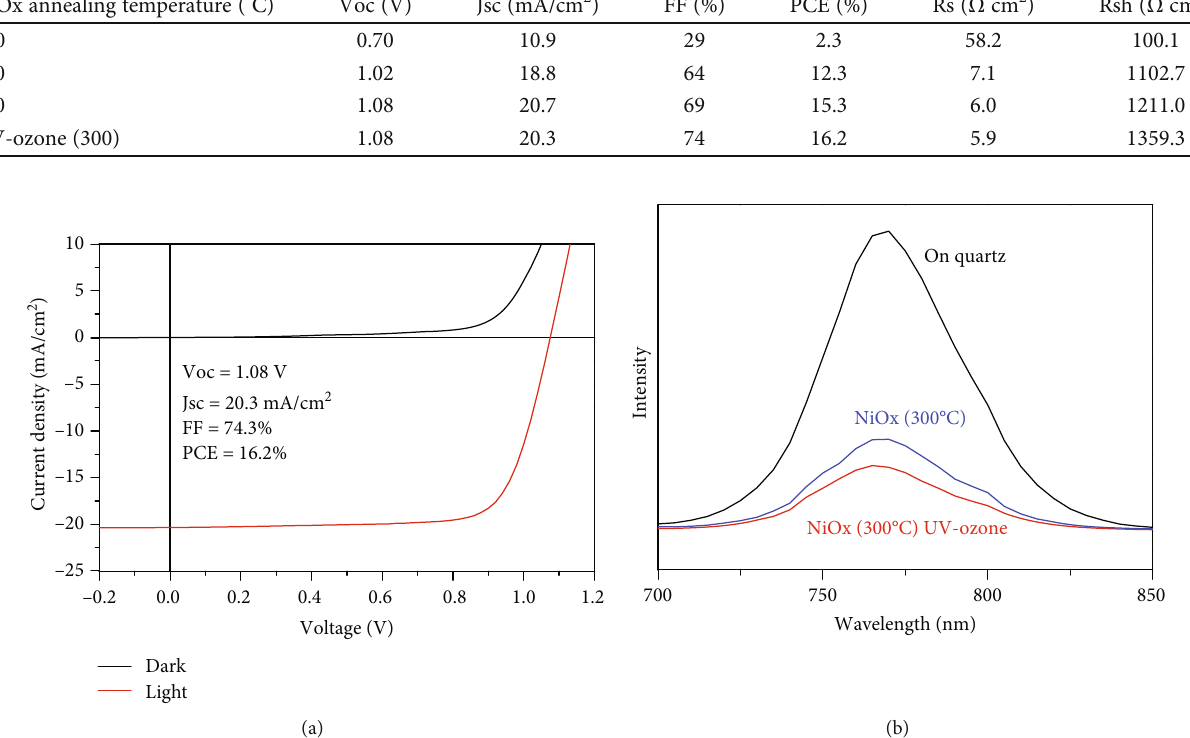
Table 1: The photovoltaic performance of PSCs based on NiOx fi lms annealed at di ff erent temperatures. NiOx annealing temperature ( °